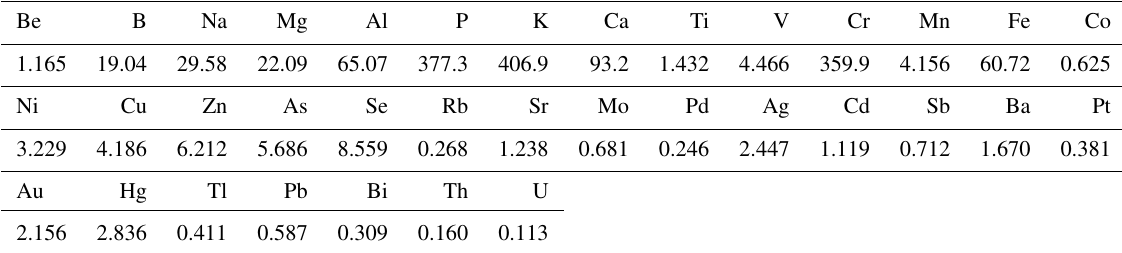
Table 2. DLs (ppb × 10 − 2 ) of trace elements determined in this study. Be B Na Mg Al P K Ca Ti V